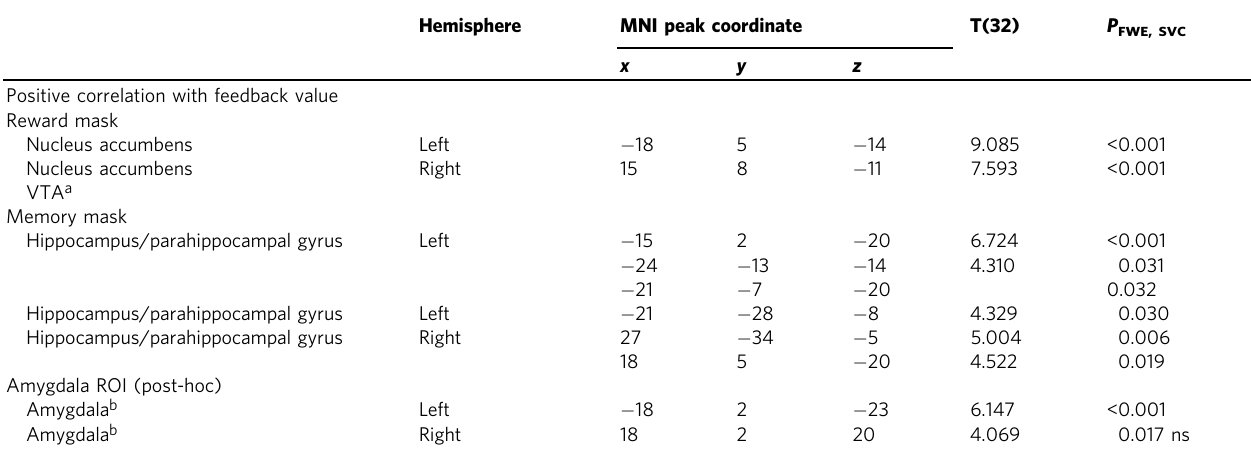
Table 2 BOLD signal showing positive correlation with increasing feedback values in a priori ROIs and the amygdala ROI.